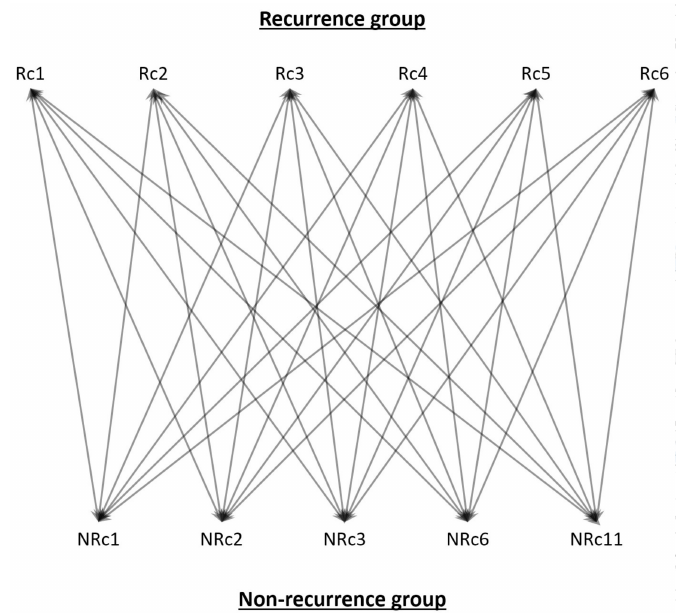
Figure 1. RNA-Seq data comparison method. RNA-Seq data of liver grafts from recipients with ( n = 6) or without ( n = 5) post-transplant hepatocellular carcinoma (HCC) recurrence was individually compared to identify differentially expressed genes, for which this result was used to map the frequently altered pathways. Rc, recurrence; NRc,